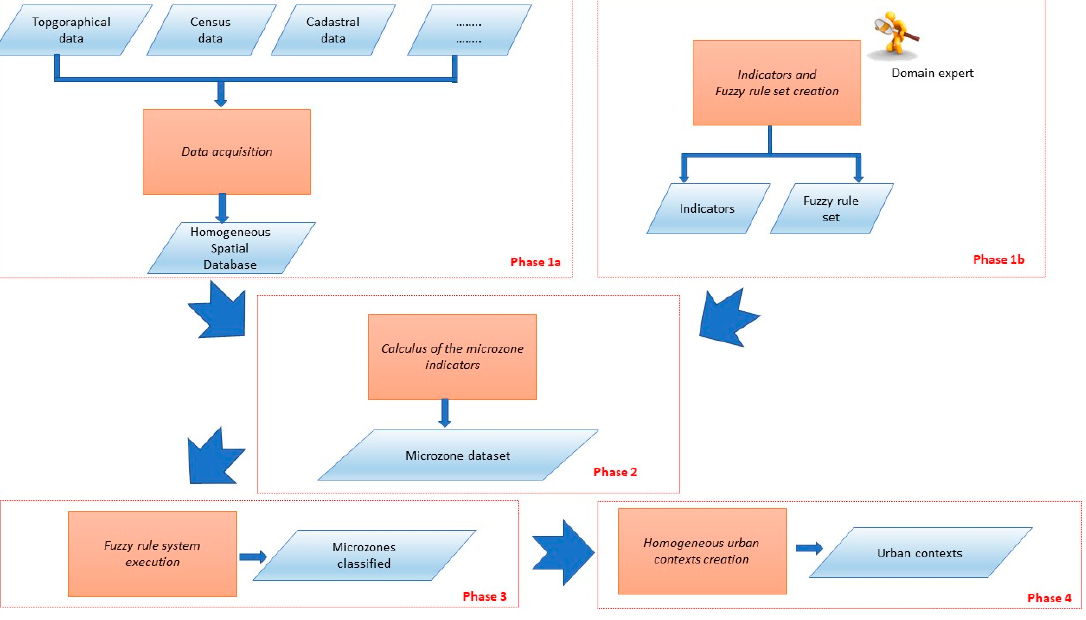
Figure 1. Scheme of the phases of the model.